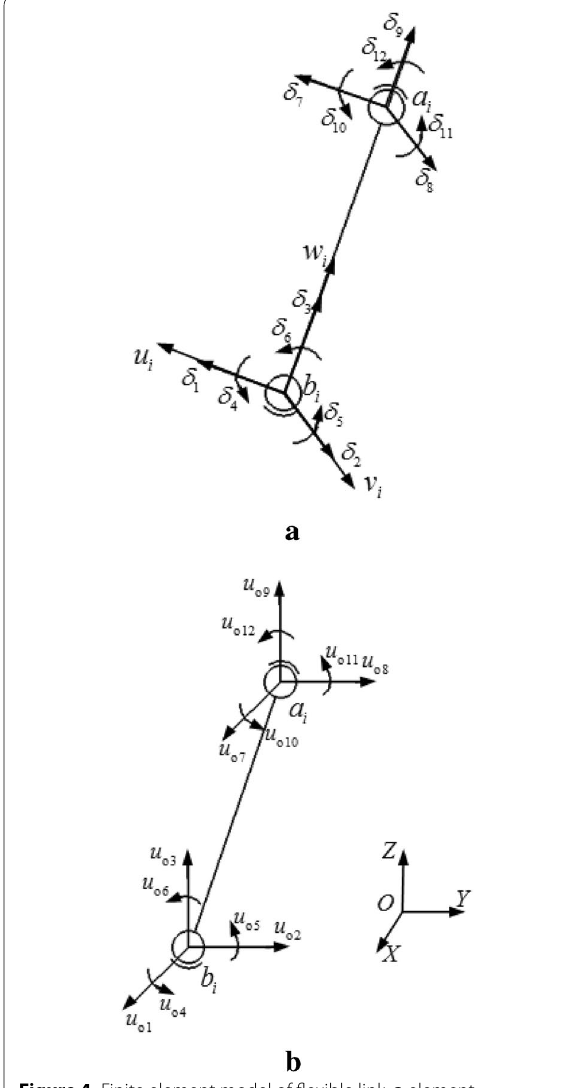
Figure 4 Finite element model of flexible link: a element coordinates; b global coordinates